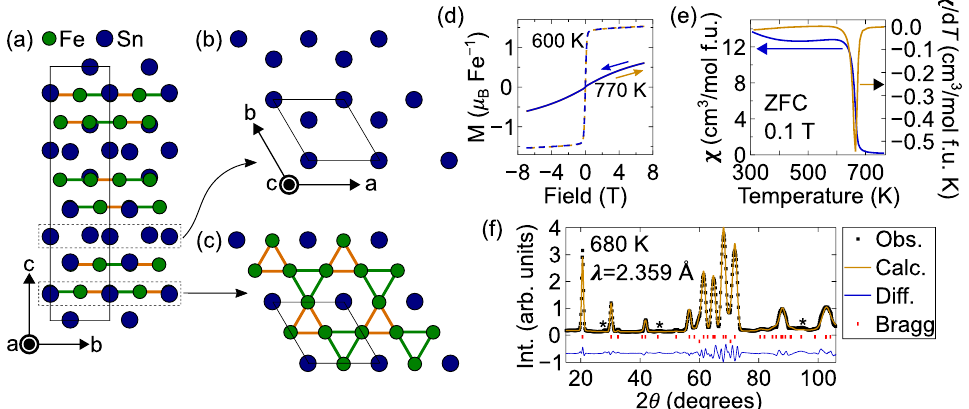
Figure 1. Crystal structure and characterization of Fe 3 Sn 2 . The crystallographic space group is R ¯3 m with reported lattice parameters a = b = 5.344 Å and c = 19.845 Å [8]. ( a ) View along the a -axis. The solid black line represents the unit cell and Fe atoms are shown as the smaller green circles and Sn atoms are shown as the larger blue circles. A single Fe site is offset from any high symmetry position ( x / a = 0.4949, y / b = 0.5051, and z / c = 0.1134) leading to two different Fe-Fe bond lengths in the ab -plane (the so-called “breathing” kagome). Two Fe-Fe bond lengths are shown, where the shorter bond is in orange, and the longer bond is in green. ( b ) A Sn-only layer viewed along the c -axis, where the Sn atoms are arranged on a honeycomb lattice. ( c ) An Fe-Sn layer viewed along the c -axis, showing the breathing kagome lattice made up of Fe atoms. The axes labels for ( c ) are the same as in ( b ), and the parallelogram outlined by a solid black line for both panels represents the unit cell. ( d ) Magnetization measurements taken at 770 K (solid lines) and 600 K (dashed lines). The samples show no signs of coercivity as the sweep down in field (blue lines) coincides with the sweep up (orange lines) in field. ( e ) Zero-field cooled (ZFC) magnetic susceptibility measurement taken in a 0.1 T applied magnetic field. The derivative (right axis) clearly shows the ferromagnetic transition at T C ≈ 665 K. ( f ) Neutron powder diffraction data taken above the magnetic transition at 680 K. The data demonstrate the structure is consistent with that reported. The upper set of red tic marks denote Fe 3 Sn 2 Bragg peak positions and the lower set denote Al Bragg peak positions coming from the sample canister. A few small impurity peaks were observed but not identified, and these are marked by the *